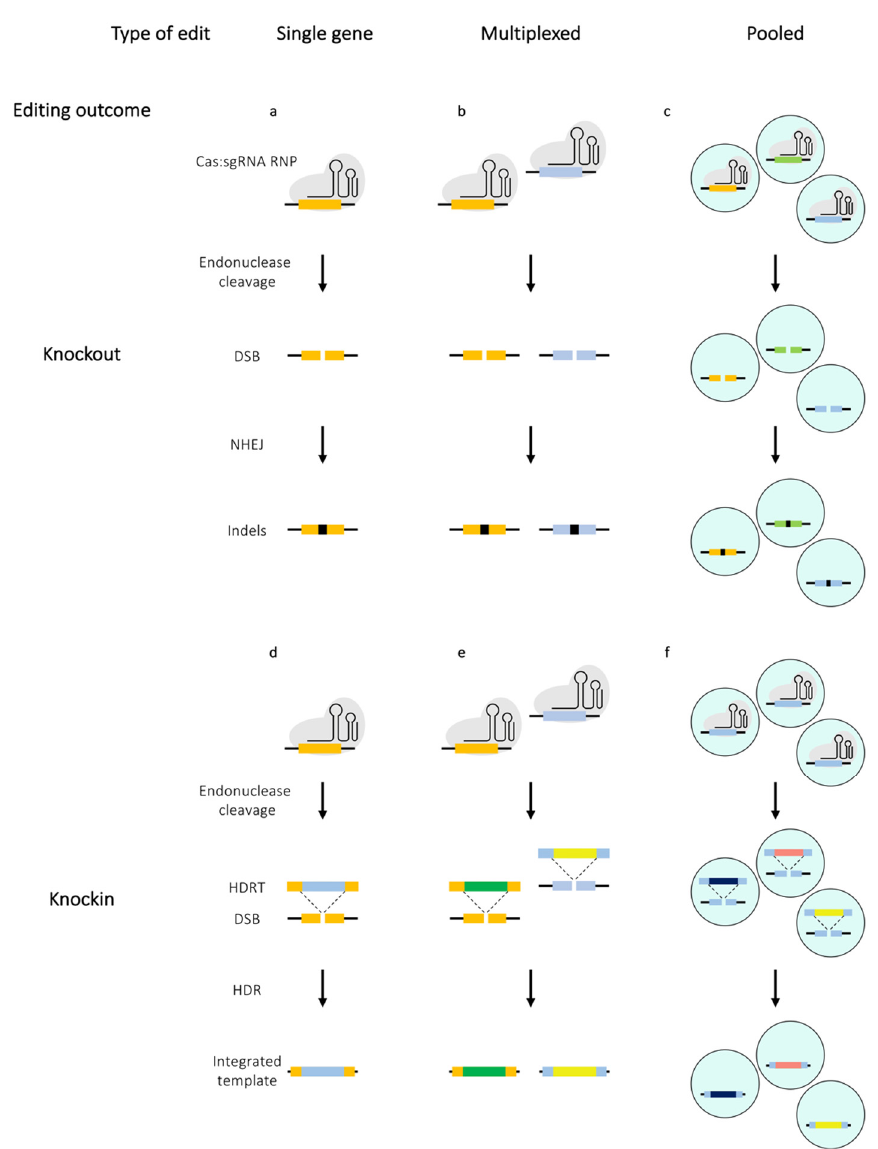
Figure 3. Summary of the most common strategies for genome manipulation in primary T cells. In terms of the resulting phenotypes, outcomes of CRISPR-based editing can be divided into knockouts ( a – c ) and knockins ( d – f ). The former results in abolition of the expression of the target gene and relies on non-homologous end joining (NHEJ) DNA repair pathway to instal indels. The latter can either result in alterations of the endogenous sequence at the target locus or an insertion of an exogenous sequence into the target locus. The new sequence is integrated via homology directed repair (HDR) and its identity is specified by an HDR template (HDRT). Both HDR and NHEJ pathways are initated by double-strand breaks (DSB). With regard to the number of loci edited per cell and the number of loci targeted in the cell population as a whole, editing strategies can be broadly divided into three types. ( a , d ) Single gene editing involves a genetic alteration at a single locus per cell. ( b , e ) Multiplexed editing results in modifications at multiple loci per cell. ( c ) The pooled knockouts aim to disrupt one locus per cell on average, however a large number of loci can be targeted in the edited population with the entire genome being screened in the extreme. ( f ) The pooled knockins involve the same locus being targeted in every cell, however the identity of the genetic modification at this locus di ff ers between the cells in the edited population. Following a pooled knockin, each cell should only have a single species of HDRT integrated into the target locus on average.